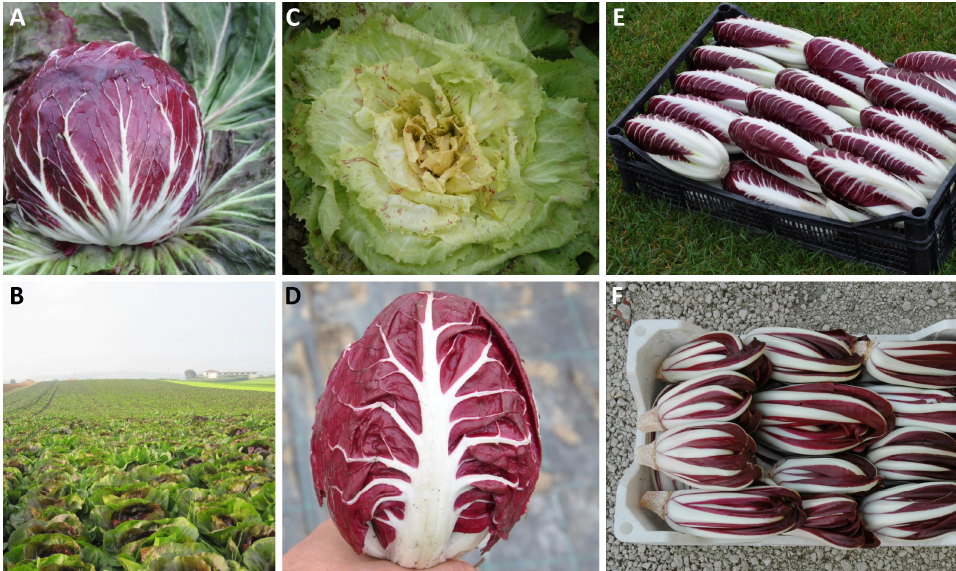
Figure 1. An overview on the main cultivated biotypes of Italian Radicchio: “Rosso di Chioggia” (Red of Chioggia, panels A and B ); “Variegato di Castelfranco” (Variegated of Castelfranco, C ); “Rosso di Verona” (Red of Verona, D ); “Rosso di Treviso Precoce” (Early Red of Treviso, E ) and Rosso di Treviso Tardivo (Late Red of Treviso, F ).